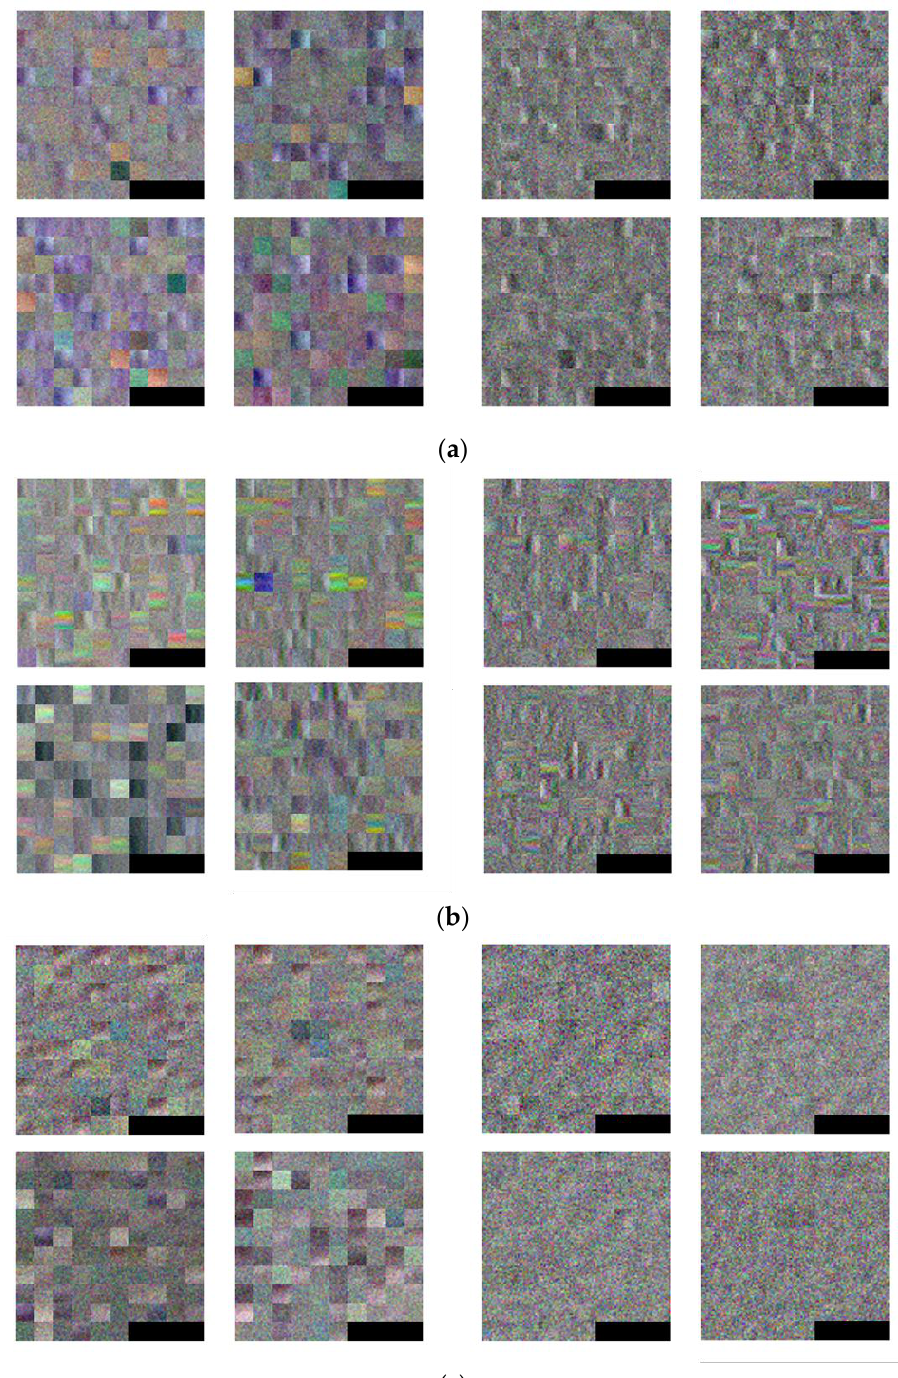
Figure 10. Examples of 96 filters obtained from the 1st convolution layer through training with ( a ) original DVLFPD-DB1, ( b ) degraded DVLFPD-DB1, and ( c ) OSU color-thermal database. In ( a – c ), left four images show the 96 filters obtained by training with visible light candidate images whereas right 4 images represent those by training with FIR candidate images. In the left and right four images, the left-upper, right-upper, left-lower, and right-lower images show the 96 filters obtained by training of 1st~4th fold cross validation, respectively.